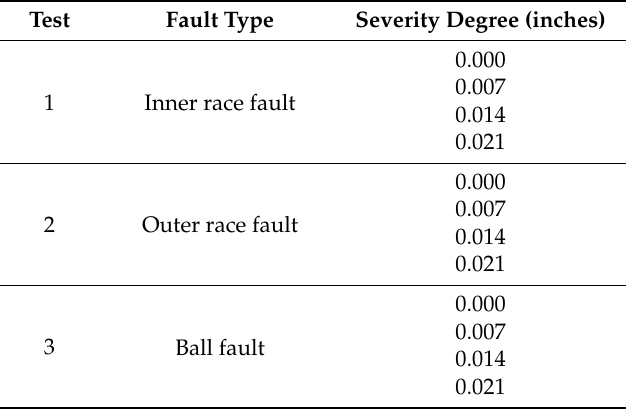
Table 1. Test arrangement of the bearing fault severity.